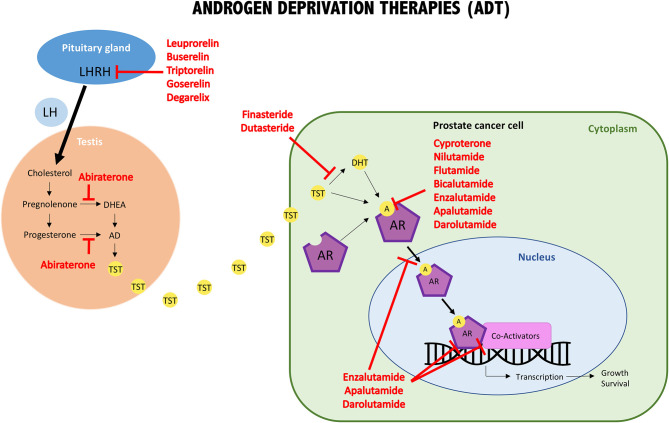
Schematic illustration of androgens/AR interaction, intracellular pathway, and molecular targets of androgen deprivation therapies (ADT). One important group of ADT drugs are the LHRH analogs. They reduce the release of LH, which promotes TST production by the testis. The other important groups are the anti-androgens, either involved in blocking androgens at the synthesis level or involved in interfering with androgen/AR binding (AR blockers). LH, luteinizing hormone; LHRH, LH releasing hormone; DHEA, dehydroepiandrosterone; AD, androstenedione; TST, testosterone; DHT, dihydrotestosterone; A, androgens; AR, androgen receptor.